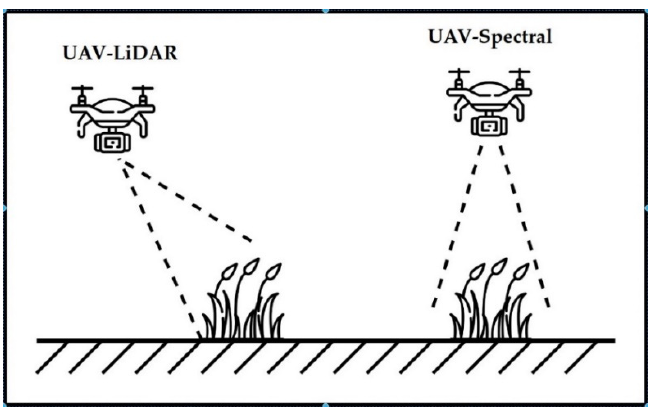
Figure 6. A schematic illustration of the difference between LiDAR and spectral data capture (adapted from Wang et al., 2021.